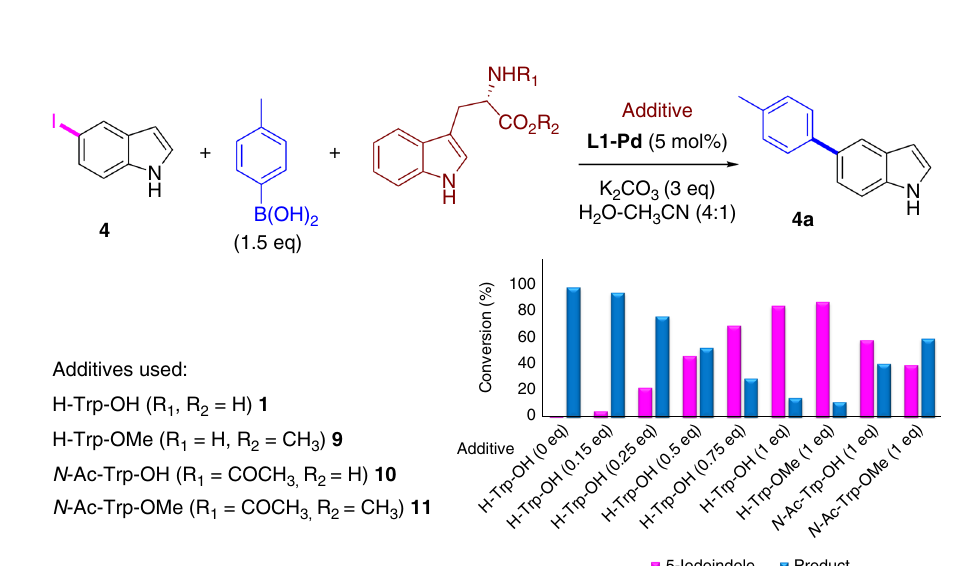
Fig. 3 Tryptophan inhibits L1-Pd catalyzed cross-coupling. Inhibition of cross-coupling of 5-I-indole 4 doped with increasing concentrations of unprotected tryptophan 1 (0 – 1 equiv.) or selectively protected tryptophans 9 – 11 (1 equiv.). Conversion was determined by 1 H NMR of the crude